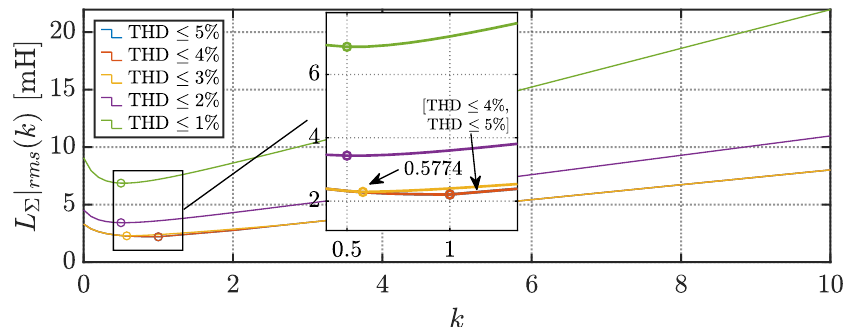
Figure 17. Converter’s total installed inductance and its optimal point at several THD limits.